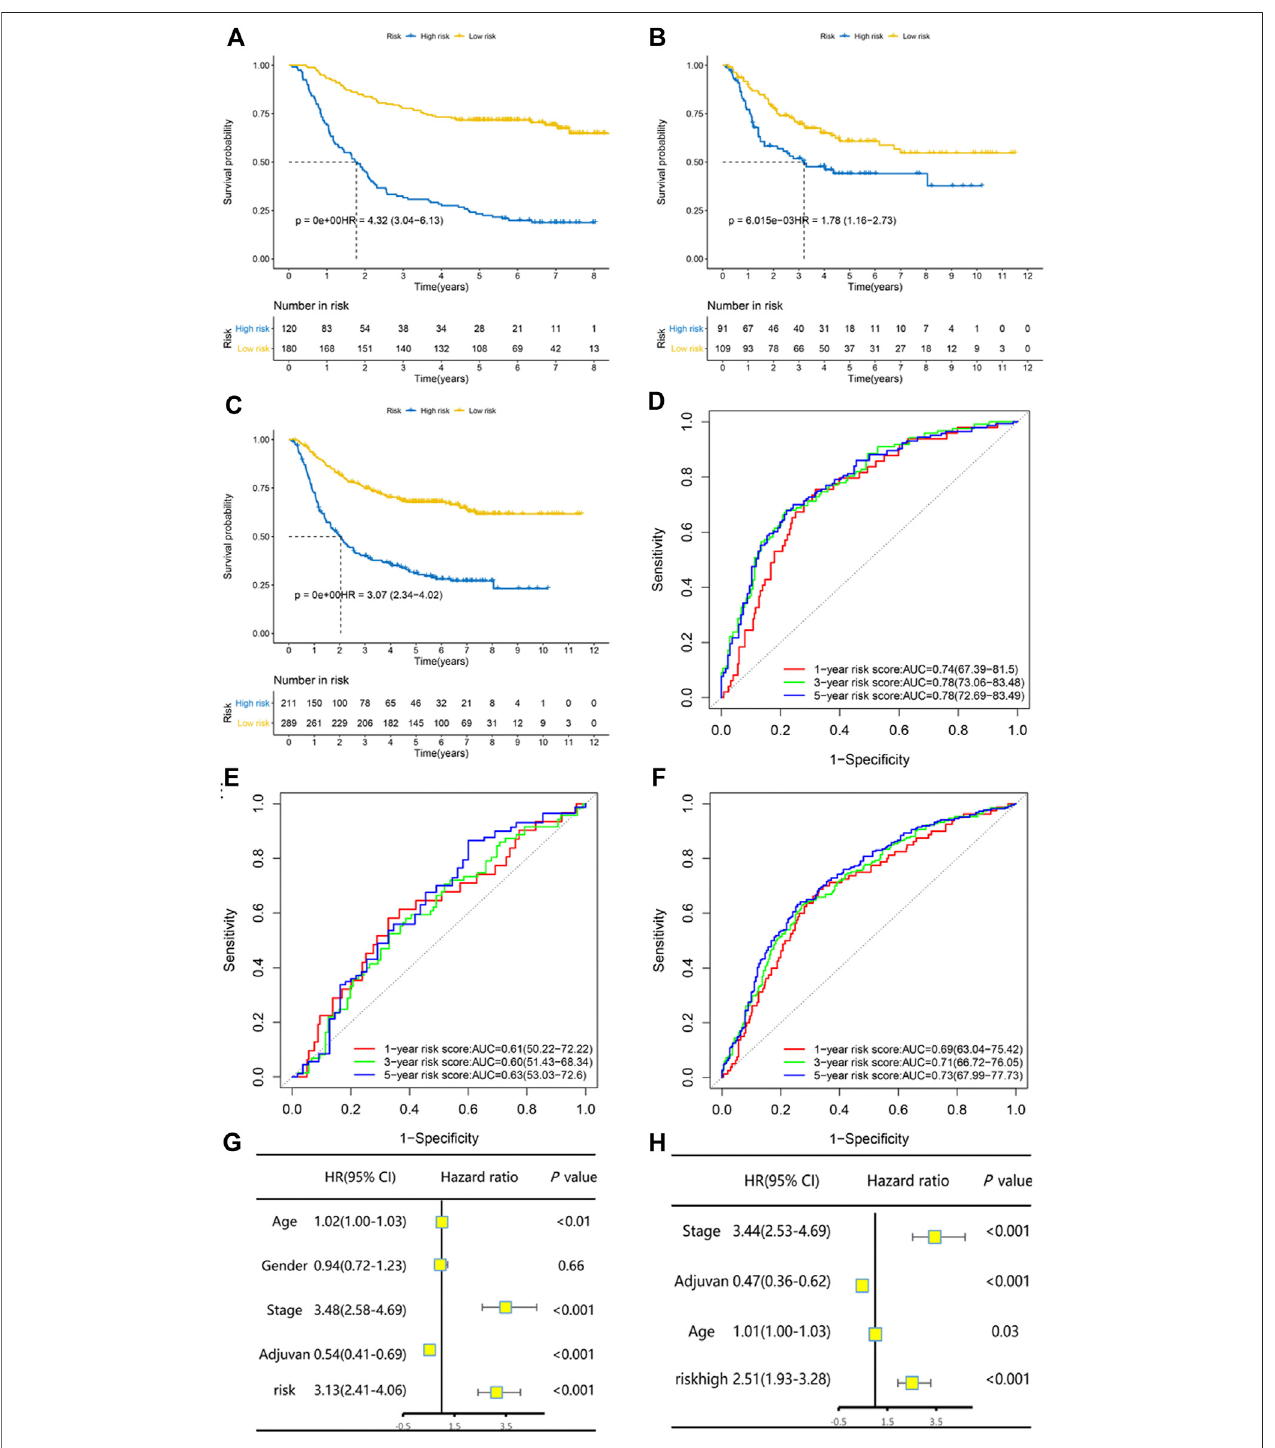
FIGURE1| Theriskpredictivescoremodelhadhighef fi cacyofpredictioninthetrainingset,thevalidationset,andthecombinationofbothdatasets.Kaplan – Meier curves of overall survival strati fi ed by risk score (low/high) in the training set (A) , validation set (B) , and both datasets (C) . Time-dependent ROC analysis for the risk predictivemodelat1,3,and5 yearsinthetrainingset (D) ,validationset (E) ,andbothdatasets (F) .Univariateandmultivariate Coxregressionanalysisforoverallsurvival in both datasets (G – H) .